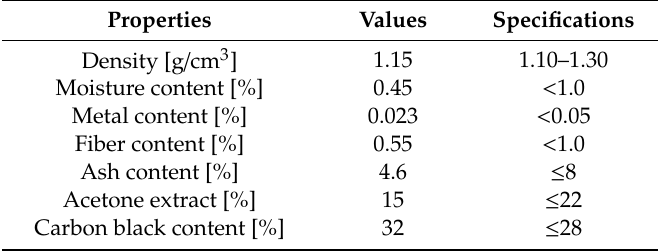
Table 2. Physical and chemical parameters of crumb rubber.